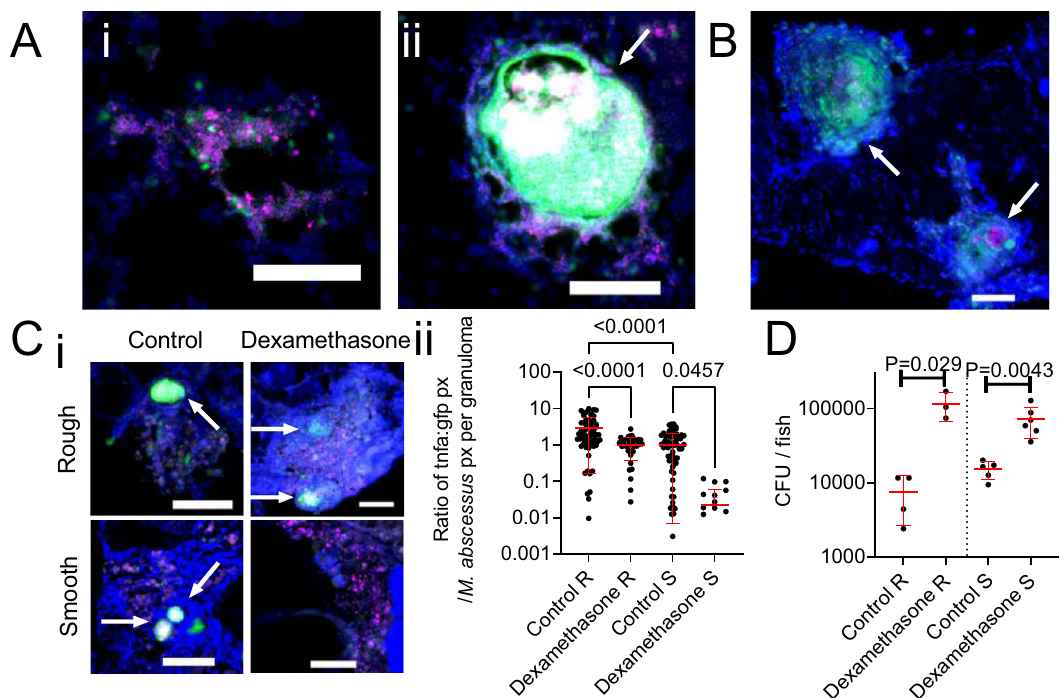
Fig. 3 Host tnfa expression is driven by M. abscessus infection and control of M. abscessus infection is sensitive to immunosuppression by dexamethasone. A Examples of R variant M. abscessus -tdTomato lesions in DAPI-stained cryosections from a 14 dpi TgBAC(tnfa:GFP) pd1028 adult zebra fi sh. i. Cellular lesion, ii. Necrotic granuloma. Arrow indicates necrotic granuloma, M. abscessus -tdTomato is coloured magenta, tnfa promoter induction is marked in green. Scale bars indicate 100 μ m. Images are representative of two biological replicates of 3 animals per replicate. B Examples of S variant M. abscessus -tdTomato lesions in DAPI-stained cryosections from a 28 dpi TgBAC(tnfa:GFP) pd1028 adult zebra fi sh. Arrows indicate necrotic granulomas, M. abscessus -tdTomato is coloured magenta, tnfa promoter induction is marked in green. Scale bar indicates 100 μ m. Images are representative of two biological replicates of 3 animals per replicate. C i. Examples of tnfa promoter activity in 14 dpi TgBAC(tnfa:GFP) pd1028 adult zebra fi sh infected with M. abscessus -tdTomato and treated with dexamethasone as indicated. Arrows indicate necrotic granulomas, M. abscessus -tdTomato is coloured magenta, tnfa promoter induction is marked in green. Scale bars indicate 100 μ m. Control images are representative of 3 animals per M. abscessus variant, dexamethasone images are representative of 2 animals per M. abscessus variant. ii. Quanti fi cation of GFP pixels as a function of M. abscessus -tdTomato fl uorescence in TgBAC(tnfa:GFP) pd1028 adult zebra fi sh. Data are a single experimental replicate, each point represents a single granuloma, total animals per group: Control